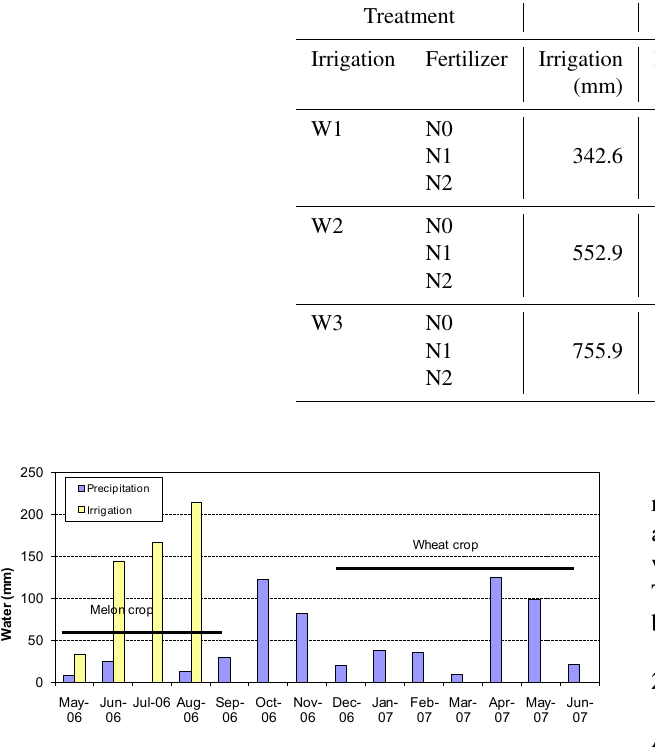
Figure 2. Monthly precipitation and irrigation applied, in millime- tres, for melon and wheat